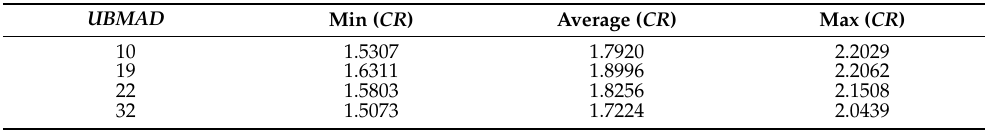
Table 5. Dependence of the minimum, maximum, and average values of CR on UBMAD for the case of DAT2 of depth 3.